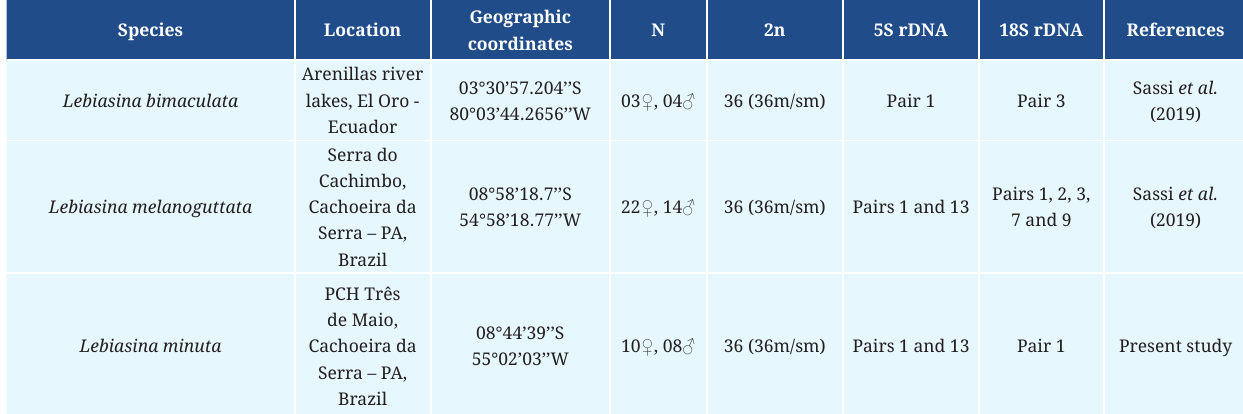
TABLE 1 | Sample sites, geographic coordinates, sampling number (N), diploid number (2n) and distribution of ribosomal DNA sequences on chromosomes of Lebiasina